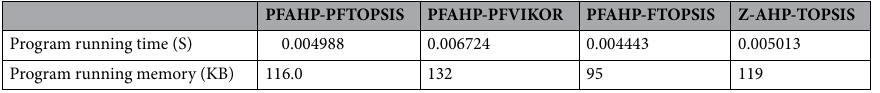
Table 16. Simulation experiment results